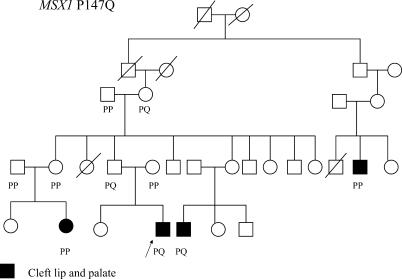
Family Pedigree of the Filipino Family Segregating the MSX1 P147Q MutationPP (proline–proline) indicates the wild-type genotype. PQ (proline–glutamine) indicates the genotype of the individuals carrying the mutation.